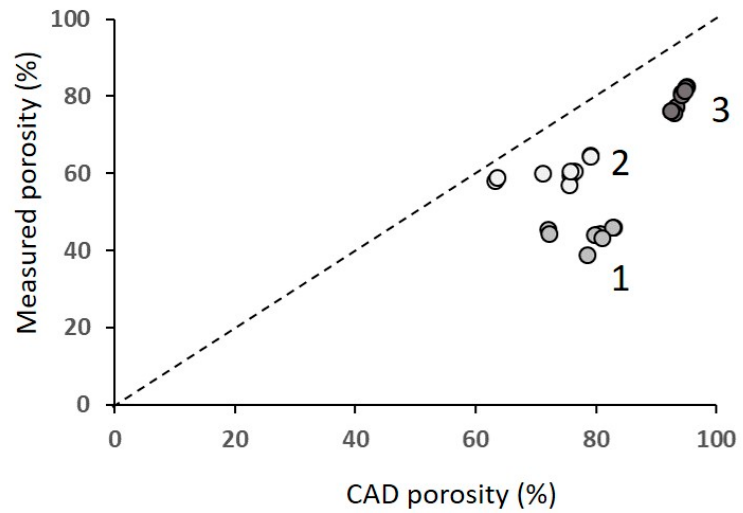
Figure 5. Actual porosity versus nominal (CAD) porosity. Numbers refer to batches: 1—highest density; 2—intermediate density; 3—lowest density.